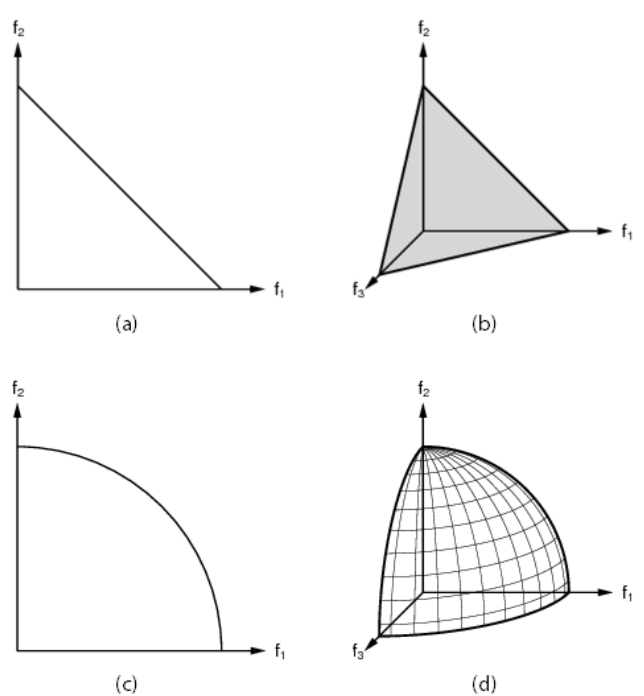
Figure 5. Optimal Pareto front for the DTLZ #1 ( a , b ) and DTLZ #2 ( c , d ) problems considering 2 and 3 objectives.